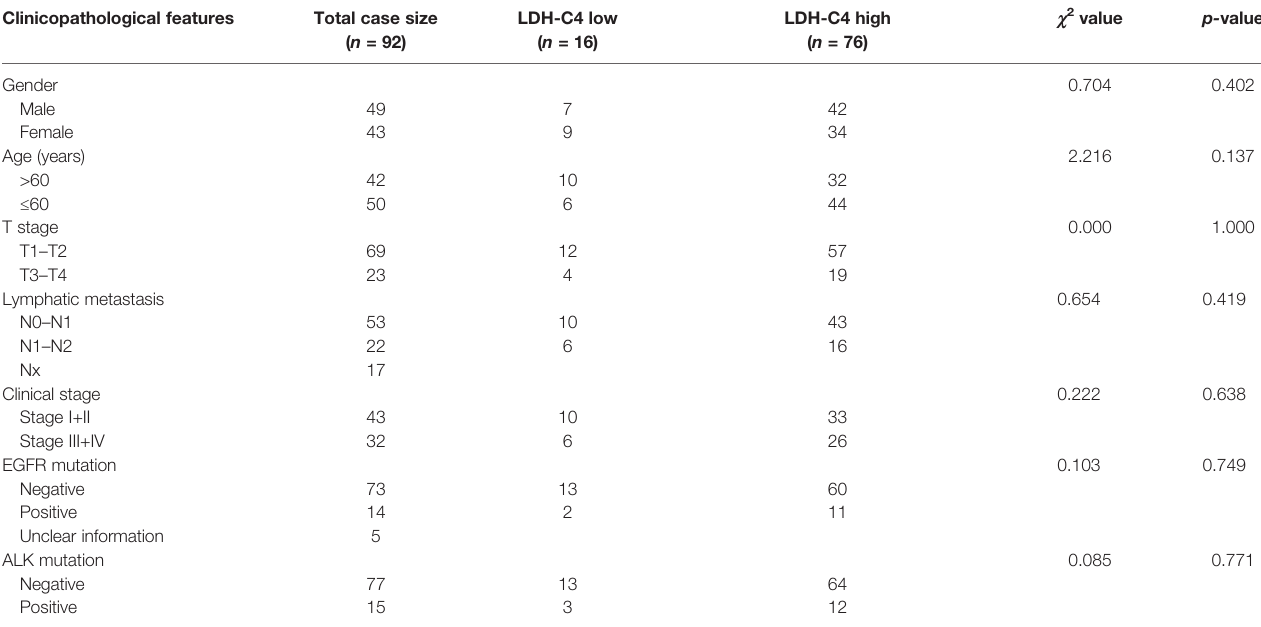
TABLE 2 | Correlations between LDH-C4 protein expressions and clinical characteristics in LUAD patients. Clinicopathological